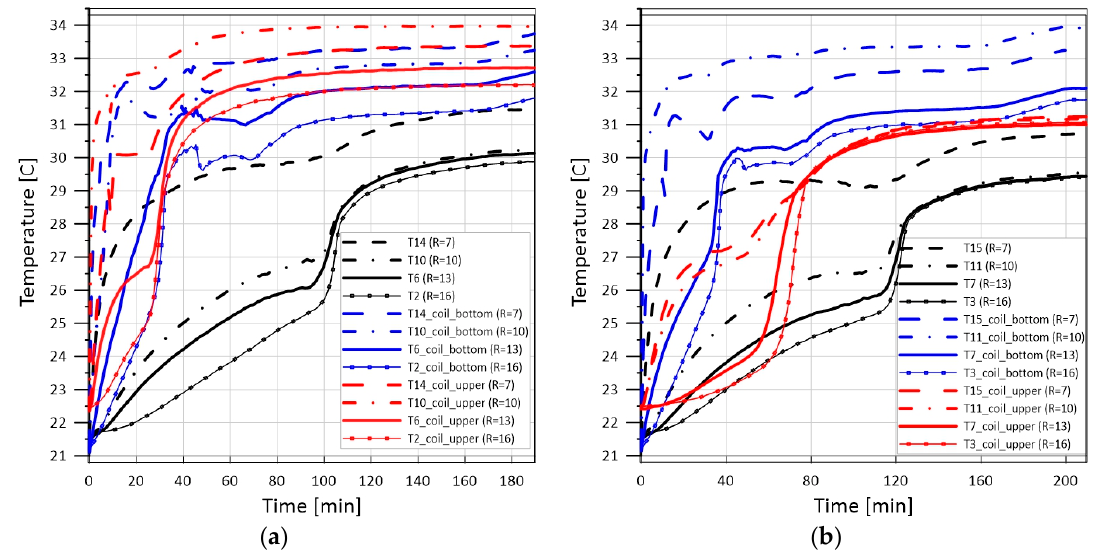
Figure 15. Temperature vs. time for increasing the radial position during the melting process with constant wall temperature condition ( Ts = 34 °C) on surfaces: S3 ( a ) and S4 ( b ).